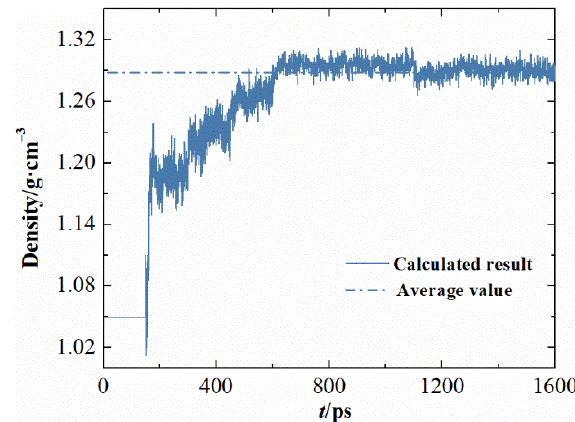
Figure 2. The density of the kerogen box.